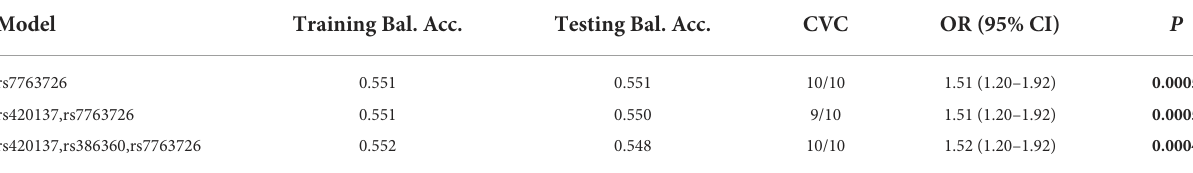
TABLE 8 Analysis of SNP-SNP interaction models using MDR method. Model Training Bal.